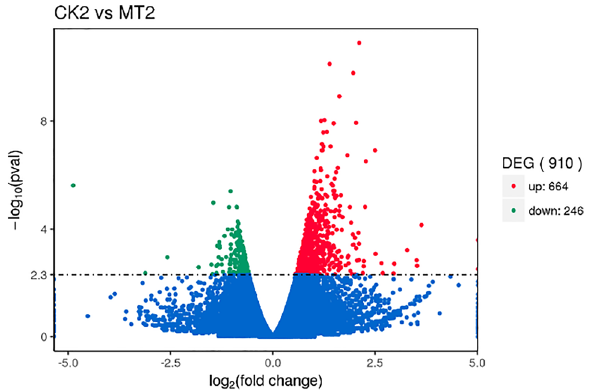
Figure 3. Volcano plots of DEGs in CK2 vs. MT2. Each dot represents one gene. Genes with no significant differences are represented by blue dots. DEGs were considered significantly different at a corrected q value < 0.005 and are represented by red dots (upregulation) and green dots (downregulation). Abscissas indicate gene expression fold changes in different samples; and ordinates represent genes with statistically significant differences in expression